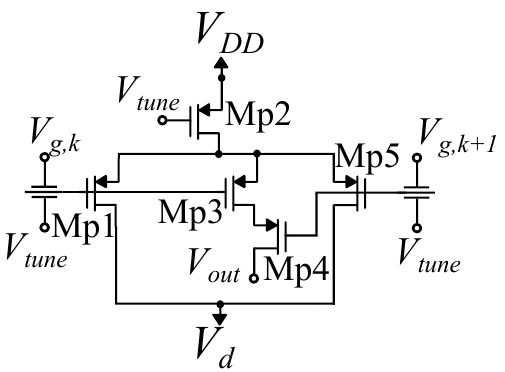
Figure 19. Schematic of a Gaussian function circuit with a floating gate transistor based inverse generation block.